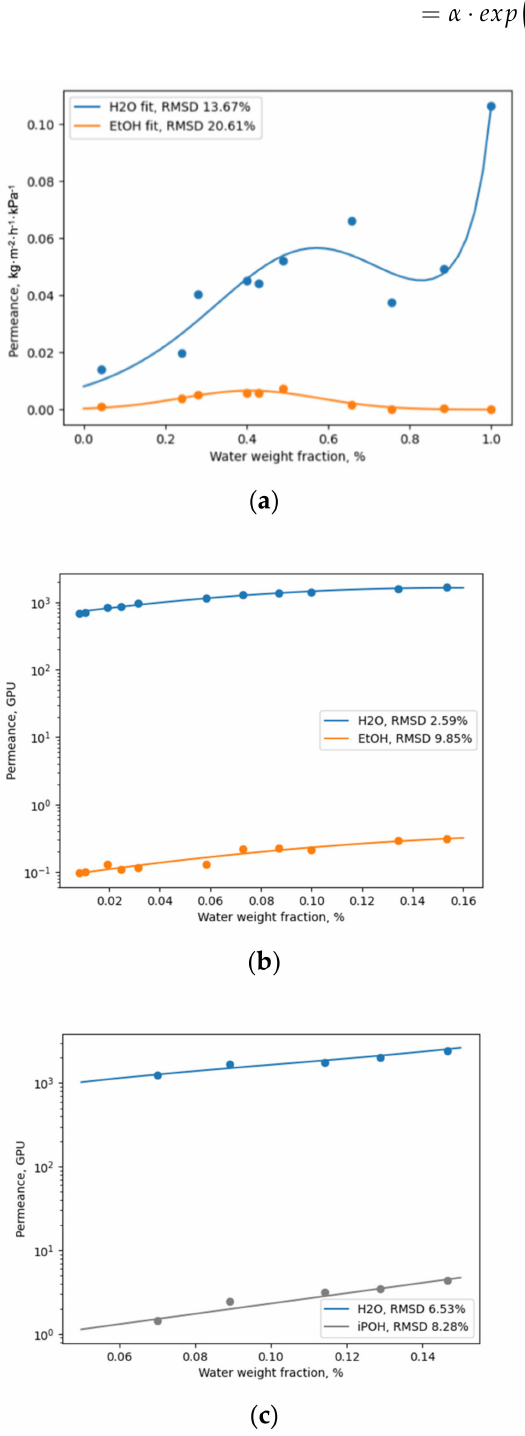
Figure 1. Illustration of experimental data approximation with Equation (13); solid lines represent fits and dots are experimental data from corresponding sources: ( a ) H 2 O/EtOH, SPI at 40 ◦ C [20]; ( b ) H 2 O/EtOH, Pervap 4101 at 95 ◦ C [24]; ( c ) H 2 O/iPOH, Pervap 2510 at 80 ◦ C